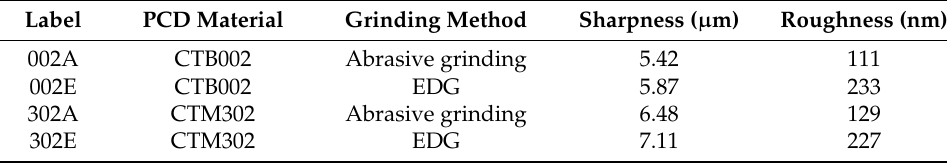
Table 5. Cutting edge radius of three PCD inserts after